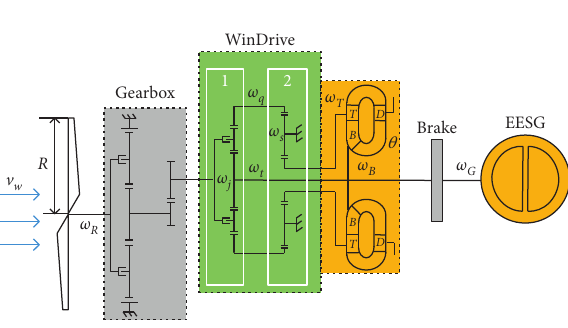
Figure 3: Structural chart of drive chain of